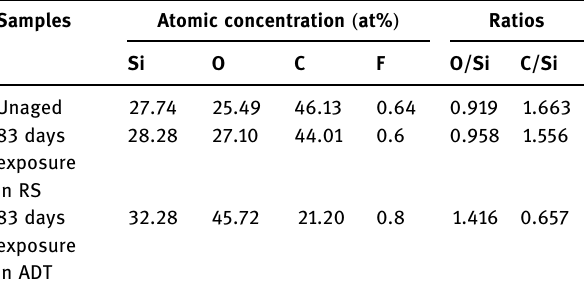
Figure 5: Stress relaxation modulus E versus time